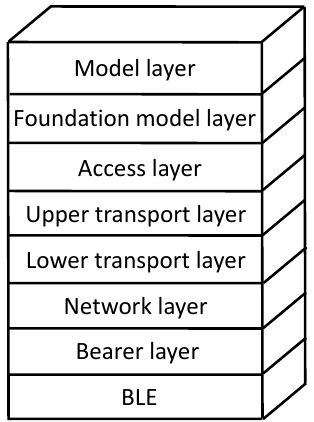
Figure 1. Bluetooth Mesh protocol stack.